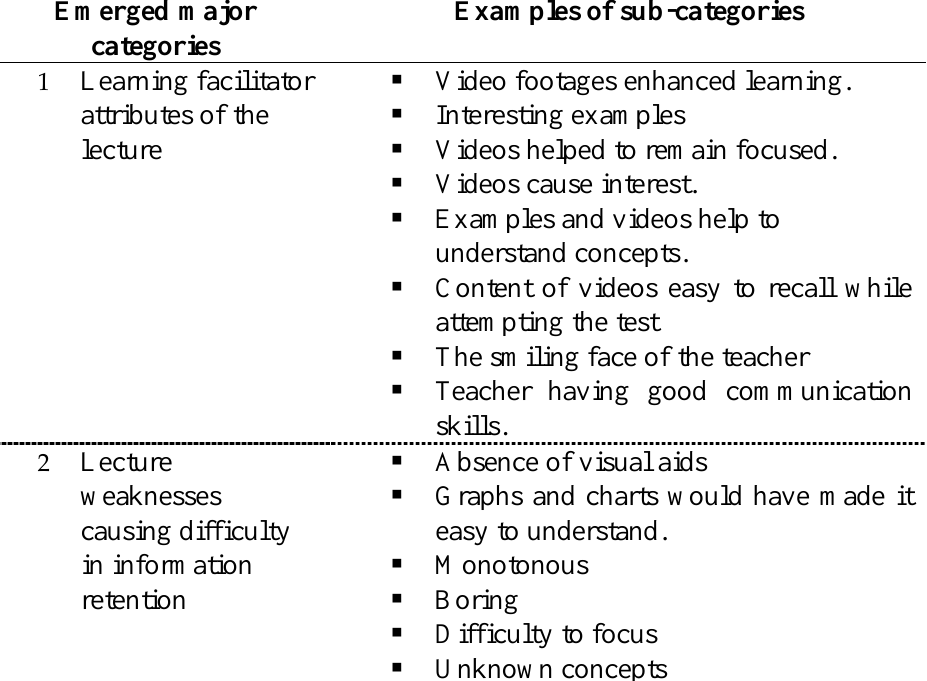
Table 2 Major categories and a few examples of sub-categories